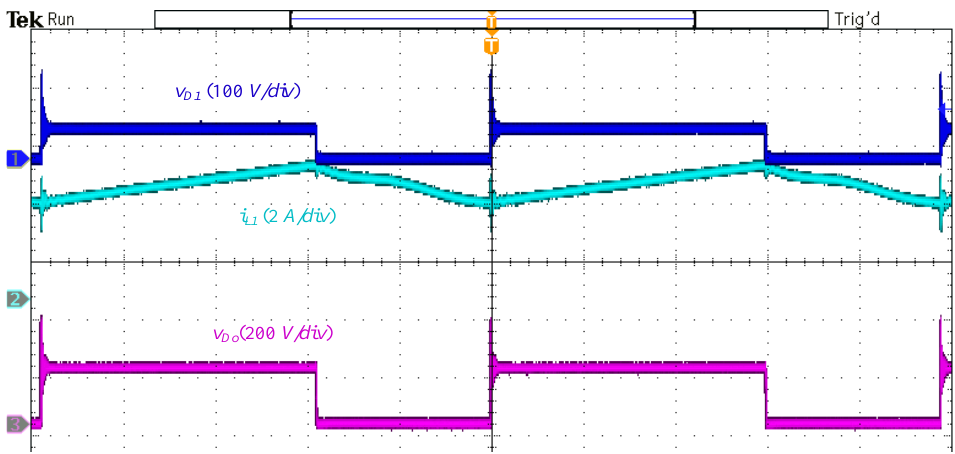
Figure 14. The inductor L 1 current, diode D 1 reverse voltage, and diode D o reverse voltage.